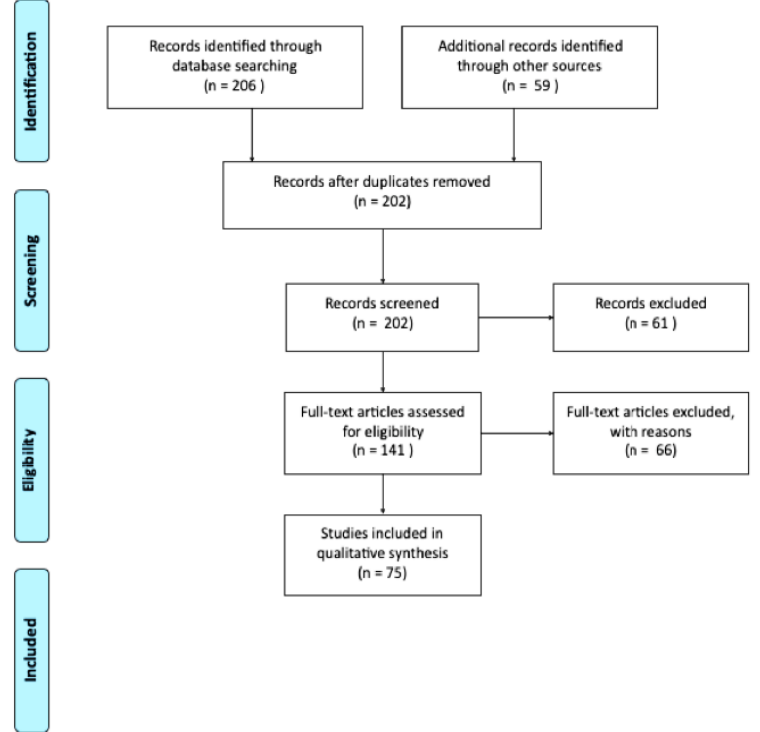
Figure 1. Preferred reporting items for systematic review and meta-analysis (PRISMA) flow chart concerning study retrieval and selection.